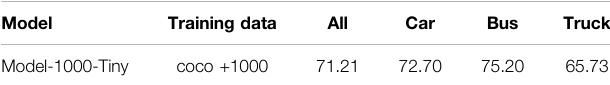
TABLE 5 | Vehicle detection accuracy of Model-1000-Tiny (mAP@0.5). Model Training data